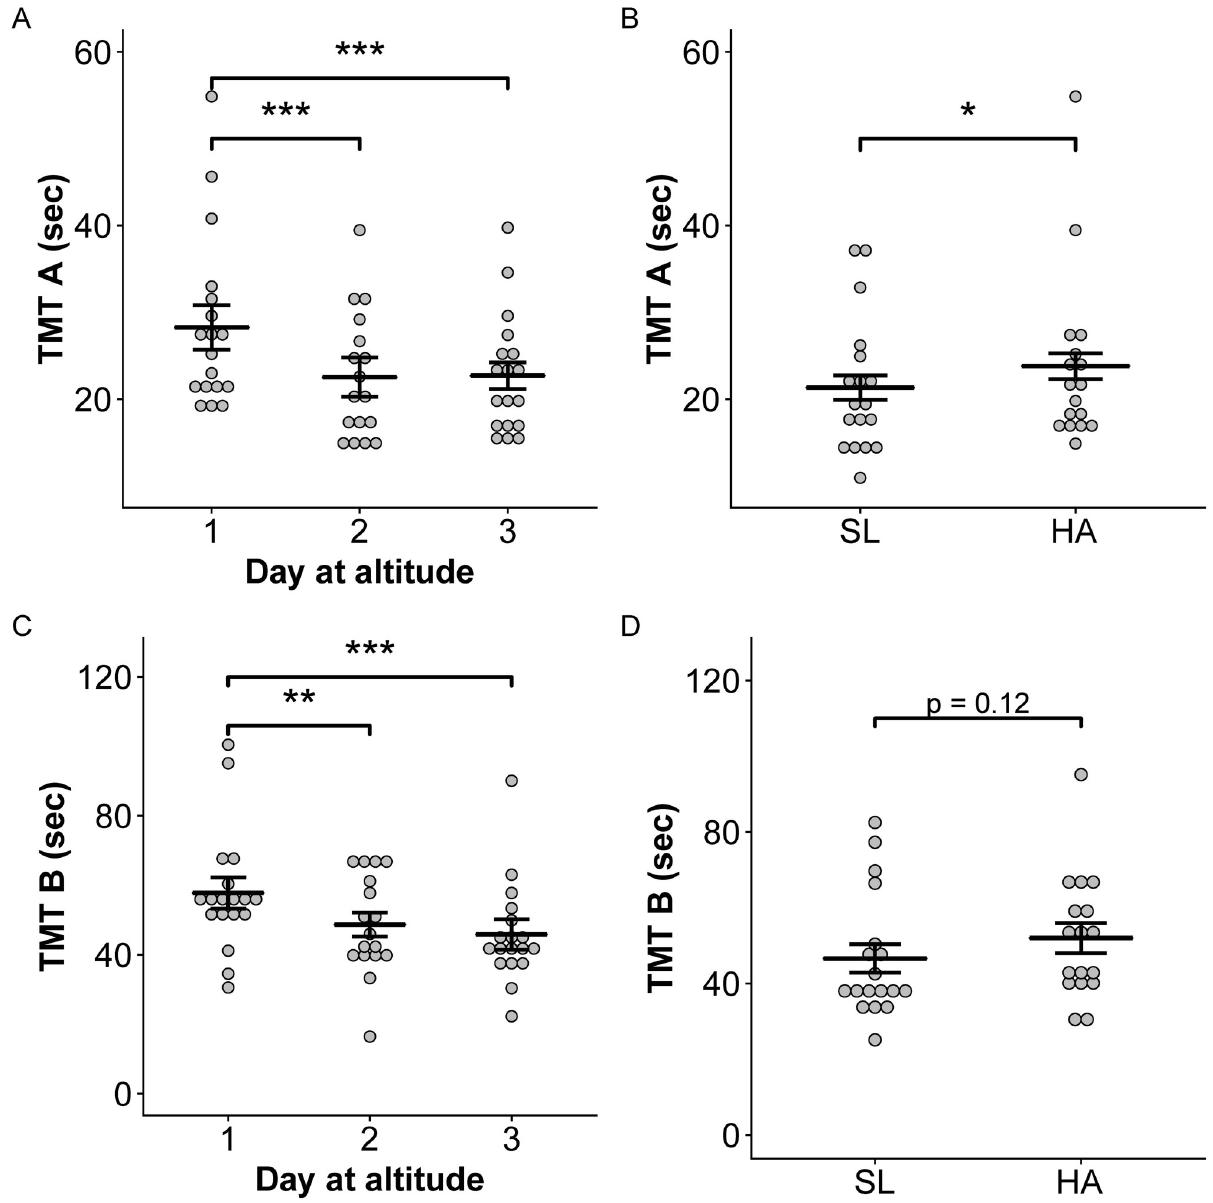
Fig 3. Performance on TMT A and B improved following acclimatization. Performance was worst (longer duration to complete task) on day 1 at altitude (A, C). TMT A scores were better at sea level than high altitude (B) but TMT B scores were not significantly impaired after ascent to high altitude (D). Means and 95% confidence intervals are provided. Asterisks indicate significant differences across groups at p < 0.05 ( � ), p < 0.01 ( �� ), and p < 0.001 ( ��� ). SL = sea level, HA = high